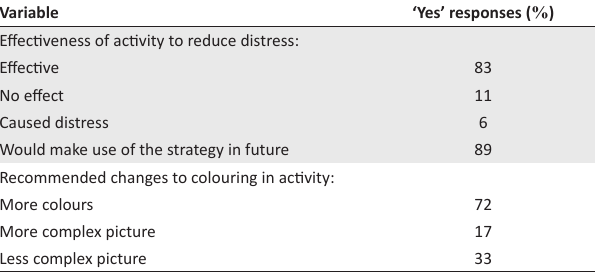
TABLE 1: Intervention group responses to colouring in activity.